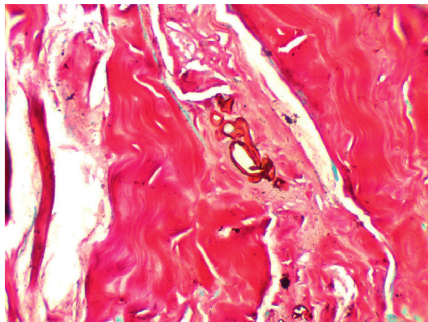
Figure 3: Silver stain of the skin biopsy showing subcutaneous mucormycosis.